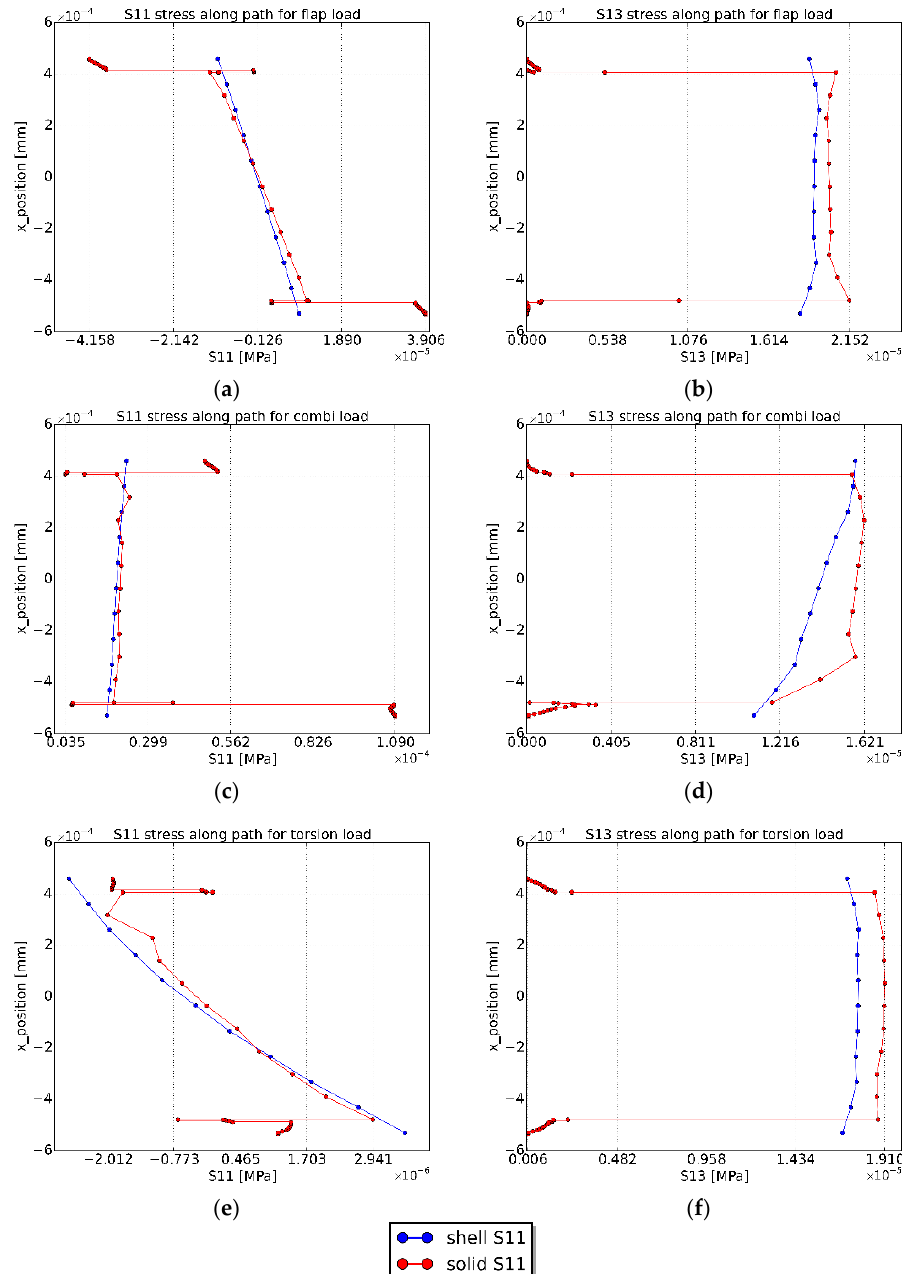
Figure 8. Plots of the stress values along a path on the side of the spar model for different load cases. ( a ) Longitudinal stress S11 for the flapwise load case; ( b ) shear stress S13 for the flapwise load case; ( c ) longitudinal stress S11 for the combined flap and edgewise load case; ( d ) shear stress S13 for the combined load case; ( e ) longitudinal stress S11 for the torsion load case; ( f ) shear stress S13 for the torsion load case.